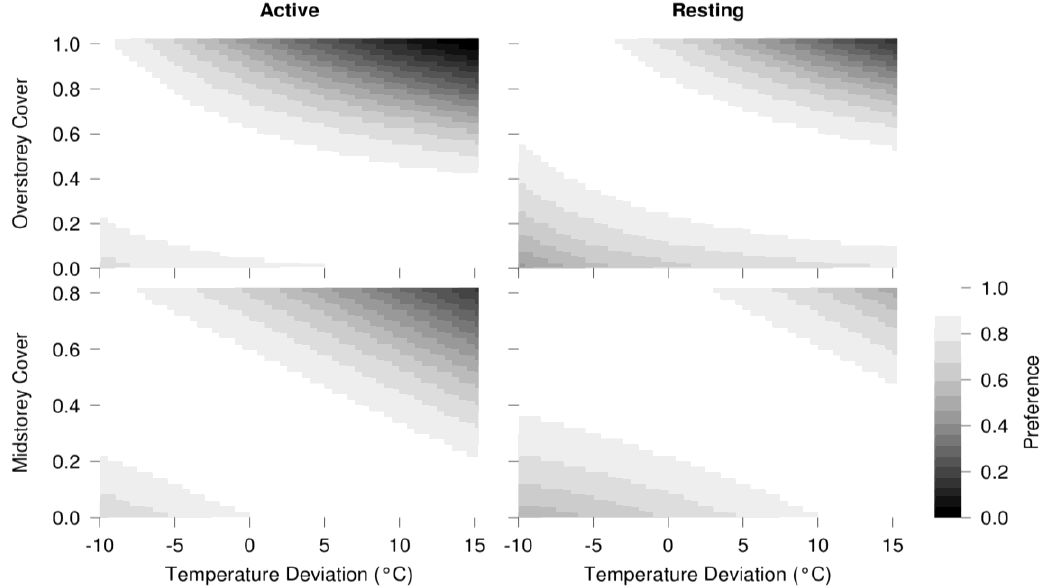
Figure 3. Predicted relative preference values for overstory cover (2 m–10 m) and midstory cover (10 m–60 m) as a function of temperature deviation from mean temperature values at given daytime for active and resting roe deer; values represent expected values estimated by mixed conditional logistic regression; not-displayed variables were set to their data set mean. Preference values were scaled between 0 and 1 to keep results between different temperatures comparable.